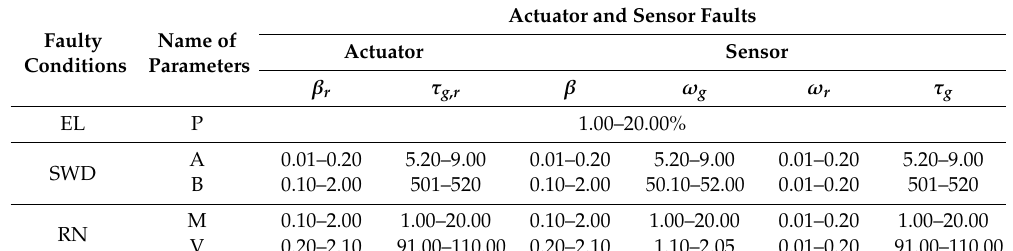
Table 4. Actuator and sensor fault signals: Experimentation